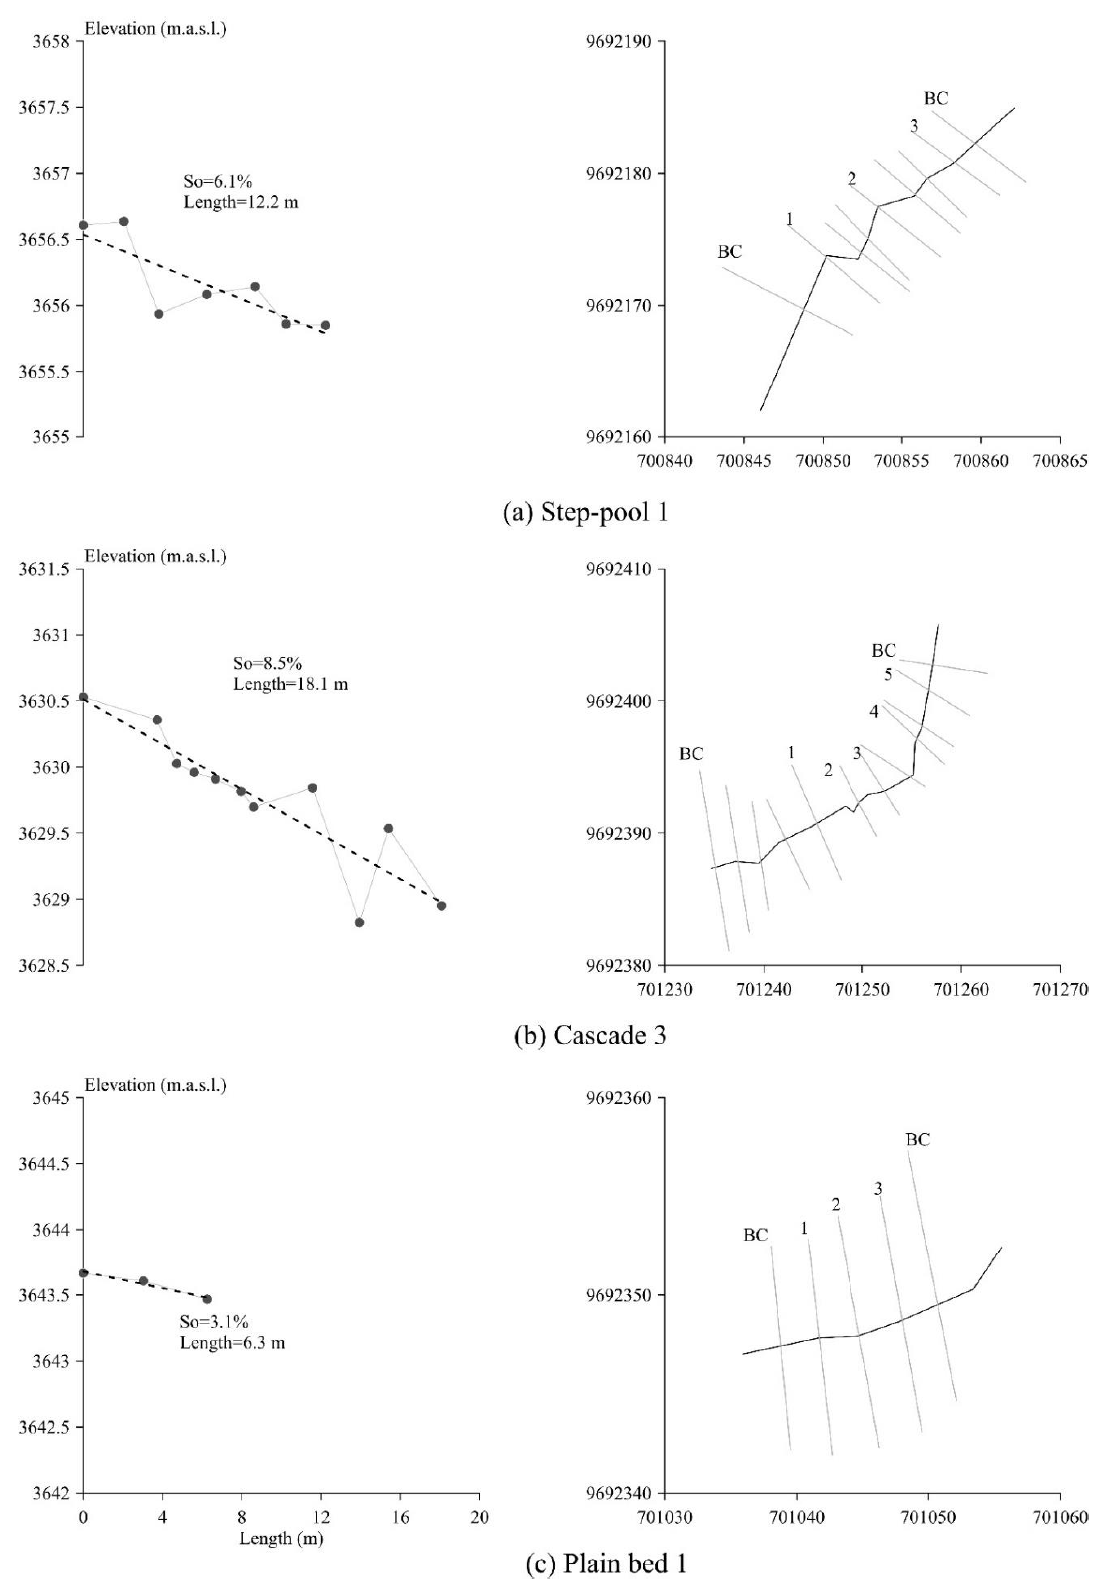
Figure 2. Profiles and topographic characteristics of morphologies under study. ( a ) Step-pool 1 ( b ) Cascade 3 ( c ) Plain bed 1.